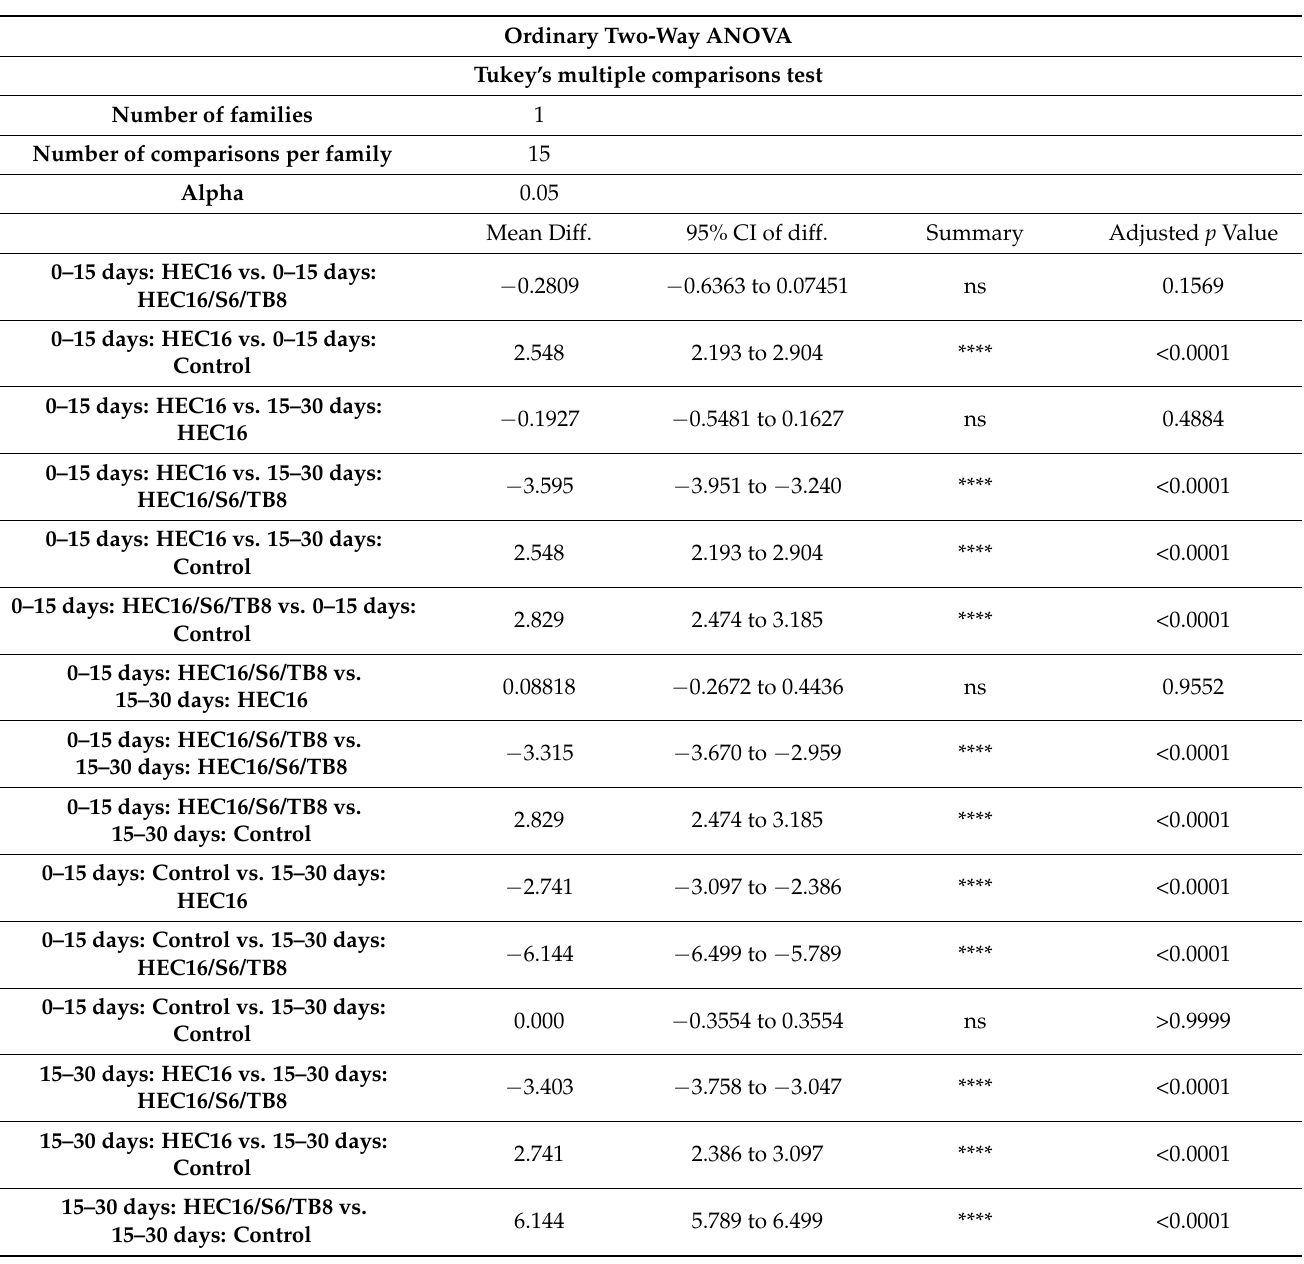
Table A10. Cont. Ordinary Two-Way